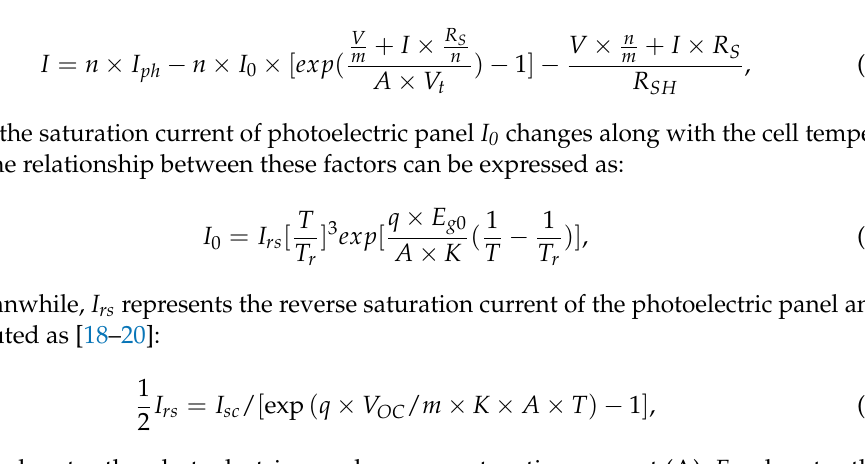
Meanwhile, I rs represents the reverse saturation current of the photoelectric panel and is computed as [18–20]: 1 where I rs denotes the photoelectric panel reverse saturation current (A), E g0 denotes the bandgap of semiconductor energy (which generally takes a value of 1 (eV)), and V OC denotes the open circuit voltage (V). According to Formula 6, a model of five photovoltaic cells connected in series is established by using MATLAB. The external interface form of the model is shown in Figure 3. The model has two input parameters: temperature and light. For example, the temperature of 25 ◦ C and the illuminance of 300 W/m 2 are shown in Figure 3. The model shown in Figure 3 is expressed as 5 photovoltaic cells connected in series, which are irradiated by a laser with an illuminance value of 300 W/m 2 when the temperature is 25 ◦ C. After photoelectric conversion, electric energy will be output through the positive and negative terminals of the model. The electric energy can be expressed in the form of current, voltage, or power. The format of the specific output will be determined by the measuring equipment connected to the model. When the model is connected to an ammeter, the current value will be displayed, and so on. Changing the input temperature and illuminance values will result in different electric energy output. Therefore,